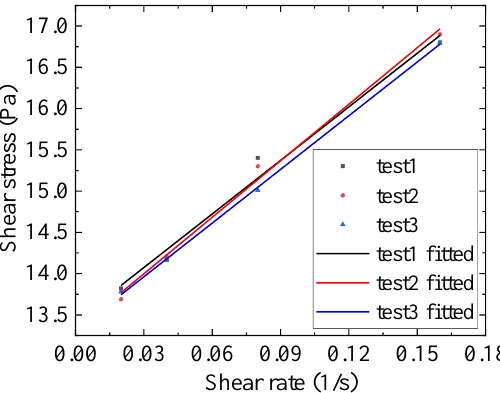
Figure A5. Initial linear stage fitting of the hysteresis loop experiment.